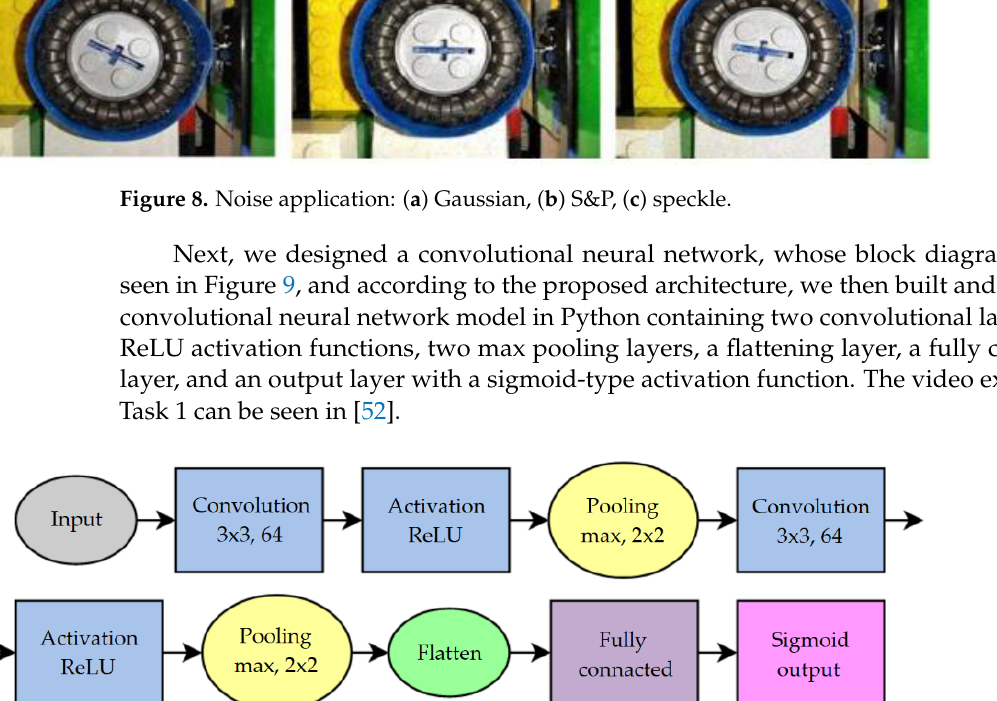
Table 1. Summary of convolutional neural network for binary classification. Layer (Type)